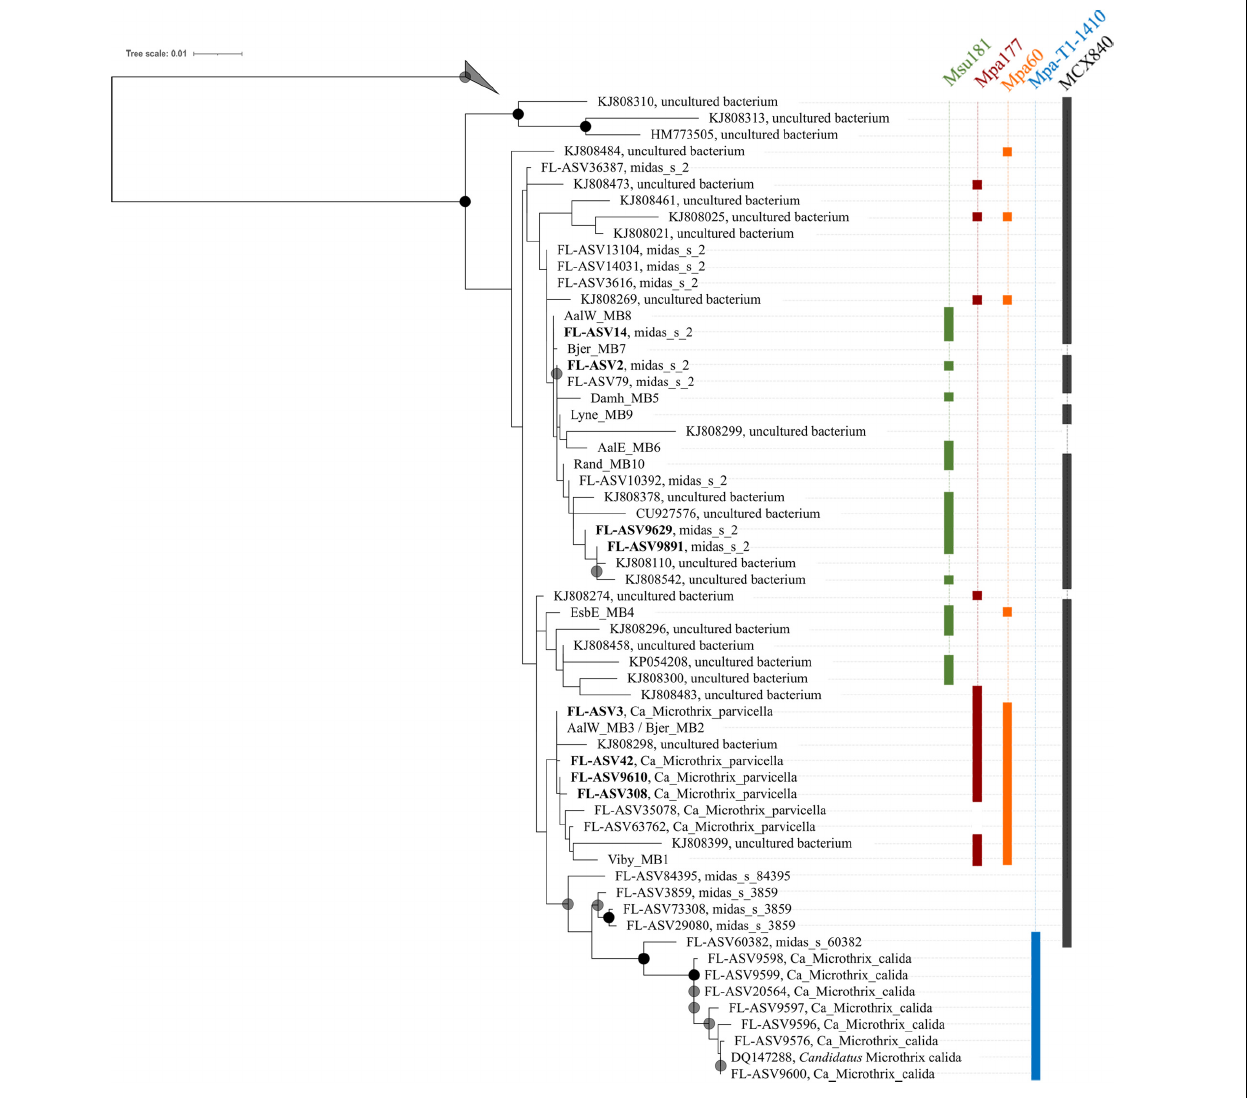
FIGURE 4 | Maximum-likelihood (PhyML) 16S rRNA gene phylogenetic tree of the genus Ca. Microthrix and coverage of new and existing FISH probes recommended for use. The tree includes full-length sequences from MiDAS4 database (FL-ASVxxx), MAG (xxxx_MBx_x) and chosen SILVA138 SSURef Nr99 (indicated by sequence accession numbers). FL-ASVs corresponding to the globally abundant ASVs are shown in bold. FL-ASVs representing Ca. M. subdominans are shown with its provisional name midas_s_2 assigned by MiDAS4.8 taxonomy. Coverage of individual FISH probes is shown in panels to the right. A 20% conservational filter was applied to the alignment used for the tree to remove hypervariable positions, resulting in 1204 aligned positions. Bootstrap values from 1000 re-samplings are indicated for branches with > 70% (gray circle), and > 90% (black circle) support. 4 FL-ASVs representing a novel genus from the order IMCC26256 were used as the outgroup. The scale bar represents substitutions per